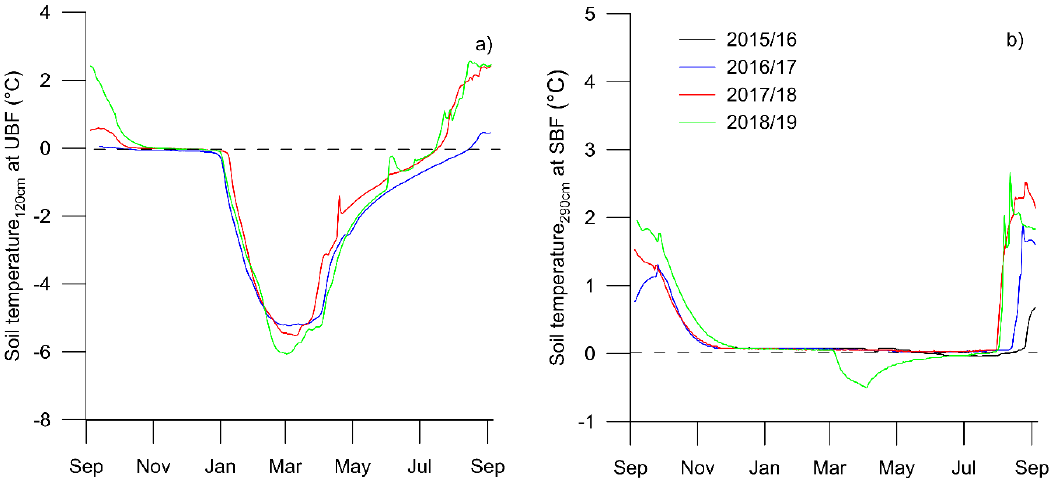
Figure 5. Temperature changes at the frost table under unburned (UBF) and severely burned (SBF) forest. The dashed line at 0 °C separates the soil freeze and thaw.